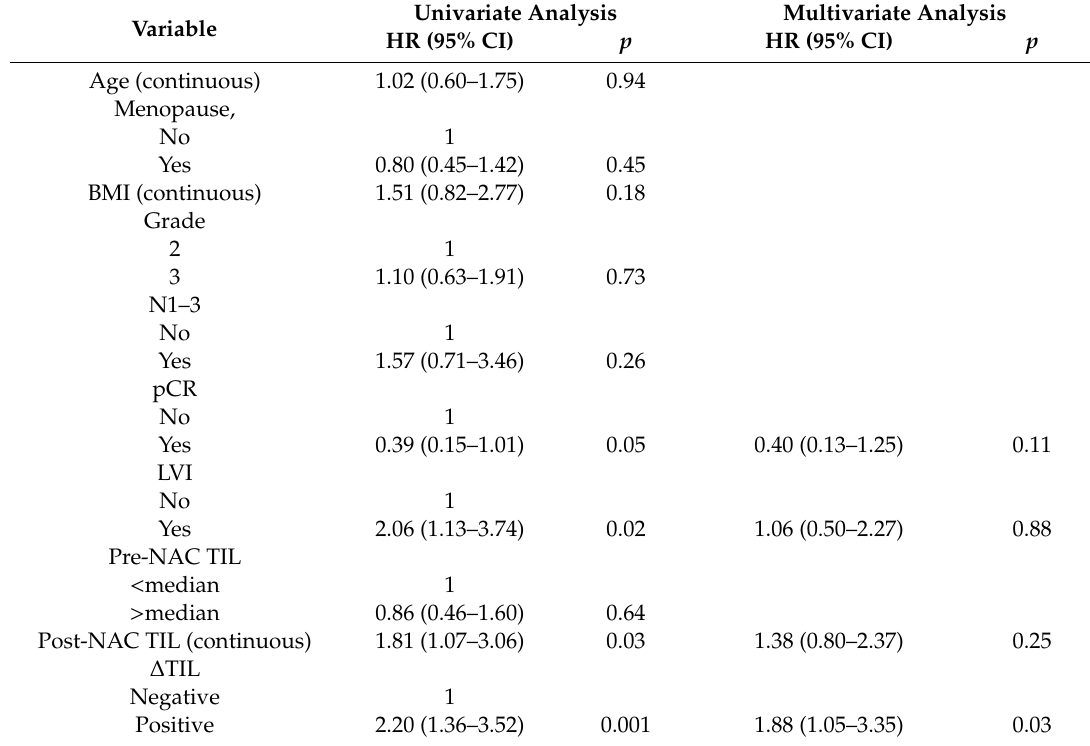
Table 2. Univariate and multivariate analysis of EFS in the whole